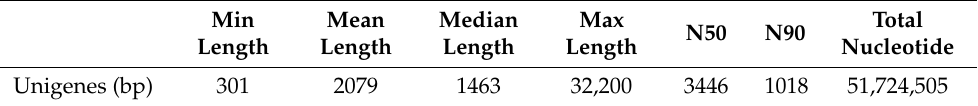
Figure 6. Length distribution of unigenes in P. kessleri FACHB-3316. Table 2. Splice length distribution of P. kessleri